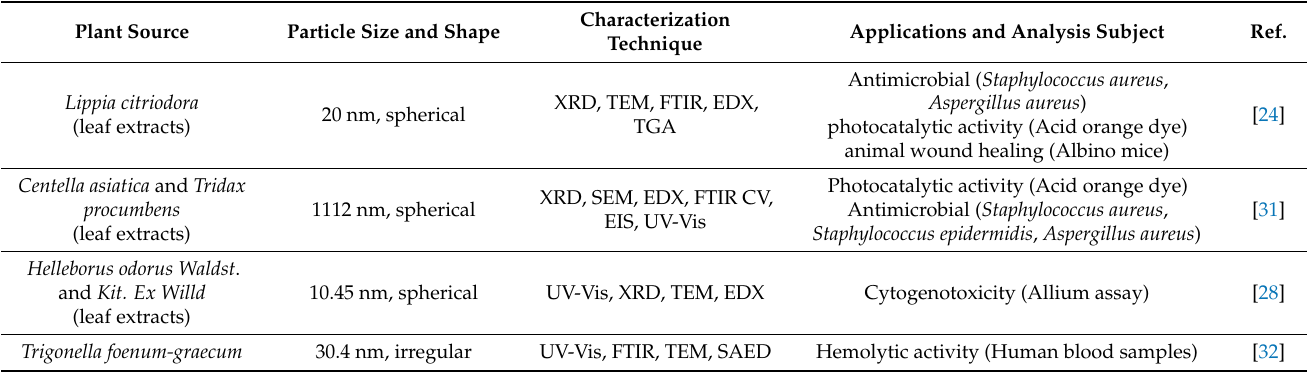
Table 1. Plant-mediated synthesis of Ag 2